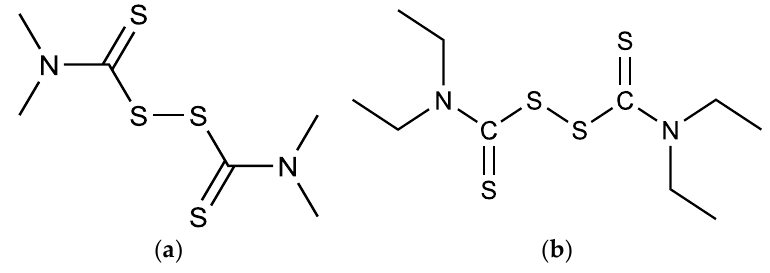
Figure 2. Structures of ( a ) thiram and ( b ) disulfiram.